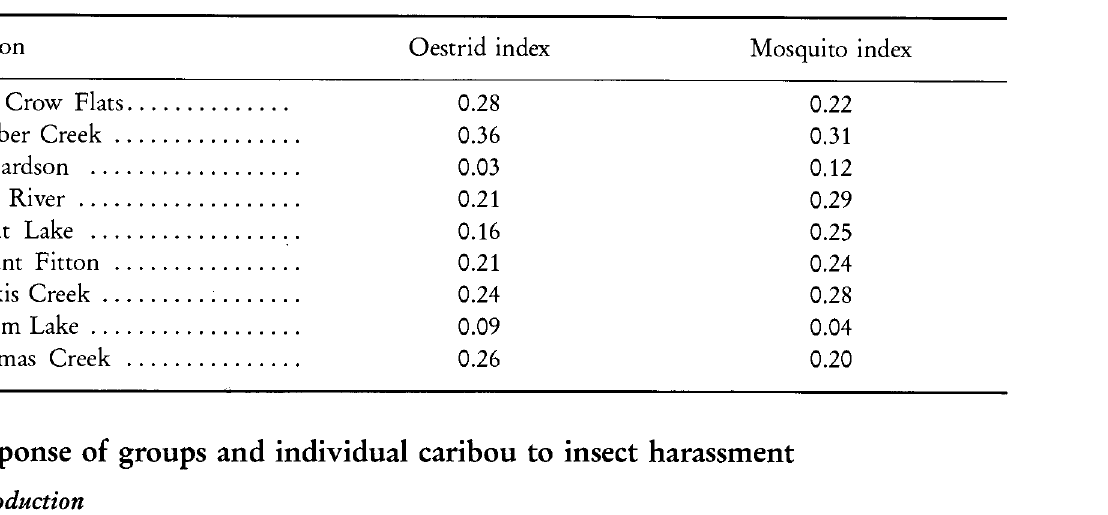
Table 4.4. Mean daily oestrid fly and mosquito harassment indices for the temporary weather stations on the summer range of the Porcupine Caribou Herd, July